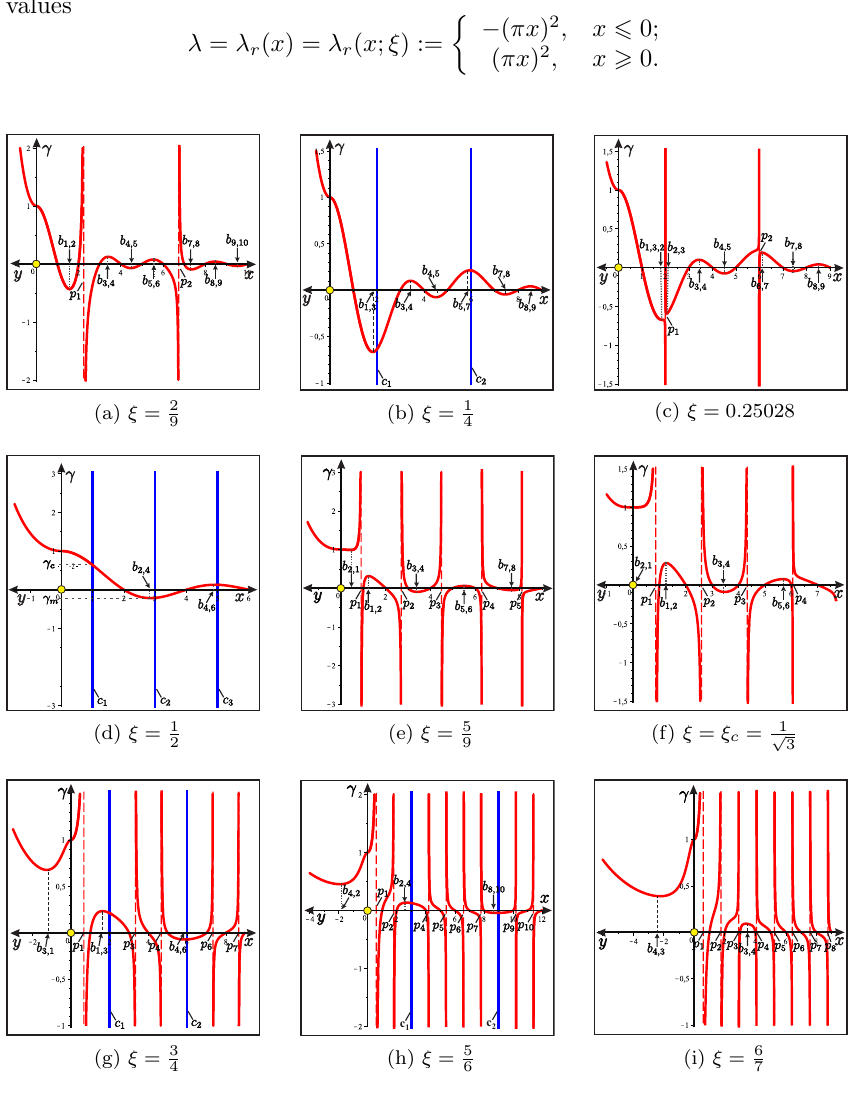
Figure 2. Real CF γ r ( q ; ξ ) for various parameter ξ